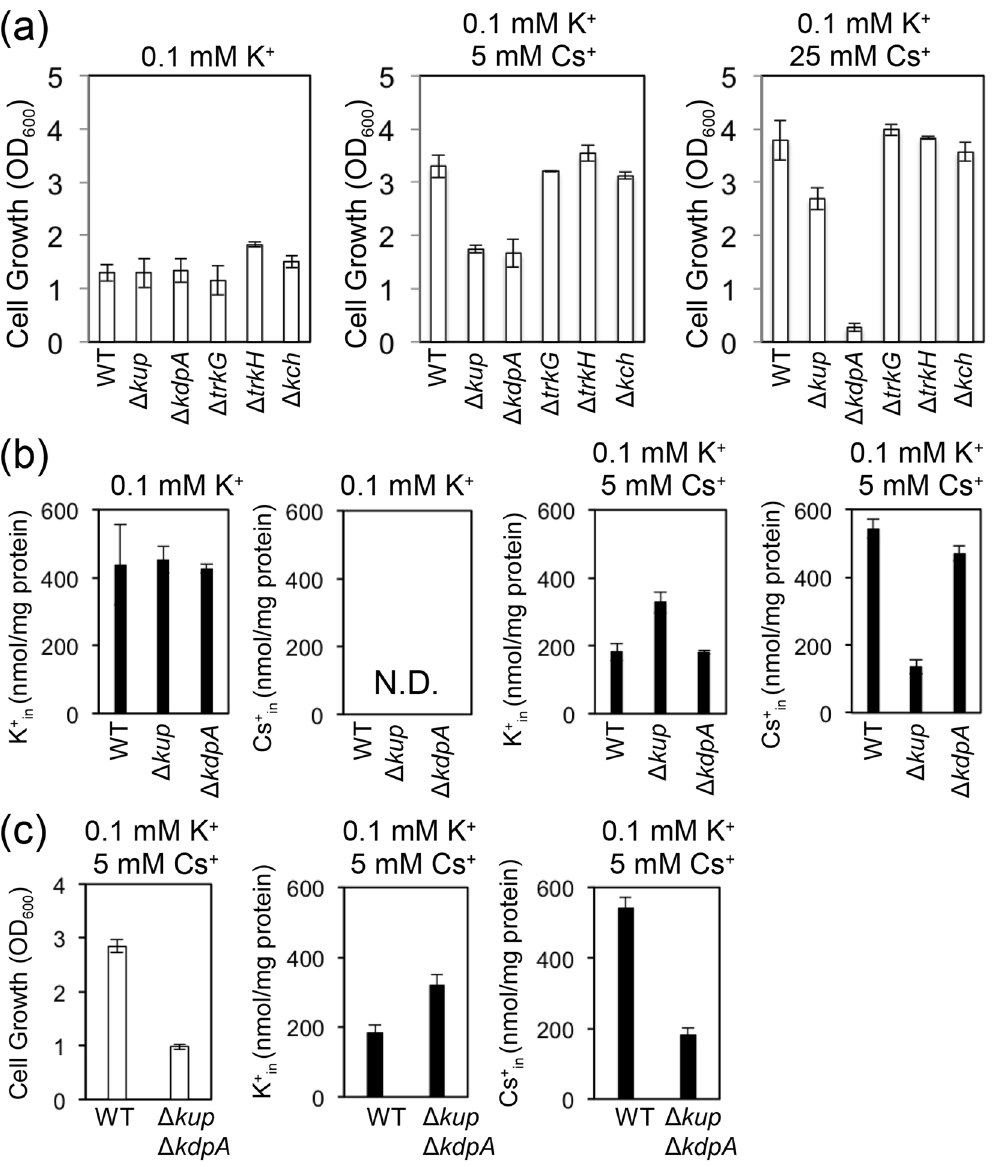
Figure 6. Requirement of K + uptake transporters under high Cs + conditions. ( a ) Growth assay of E . coli WT, Δ kup , Δ kdpA , Δ trkG , Δ trkH and Δ kch in minimal medium containing 0.1 mM K + without or with 5 mM or 25 mM Cs + , which was performed in the same experimental condition to that of Fig. 1. ( b ) The content of K + and Cs + of WT, Δ kup and Δ kdpA grown in minimal medium containing 0.1 mM K + with 5 mM Cs + measured from the data in Fig. 6a. N.D. Not detected. ( c ) The growth of WT and Δ kup Δ kdpA and their content of K + and Cs +